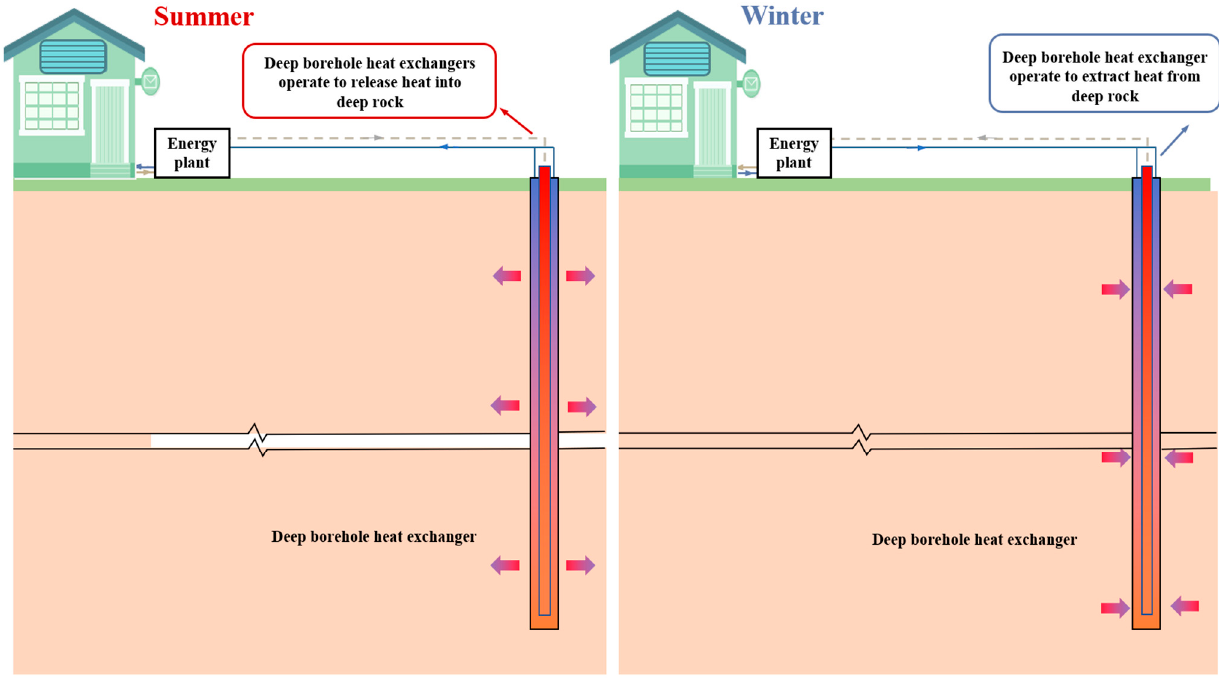
Figure 1. Schematic for charging and discharging of the deep BTES system. Heat transfer analysis of DBHE includes rock temperature evolution outside the borehole and temperature profile of the circulating fluid along depth in the inner and outer branches of the coaxial tube installed inside the borehole [23,24]. In the rock zone, three-dimensional unsteady heat transfer evolves within large spatio-temporal scales